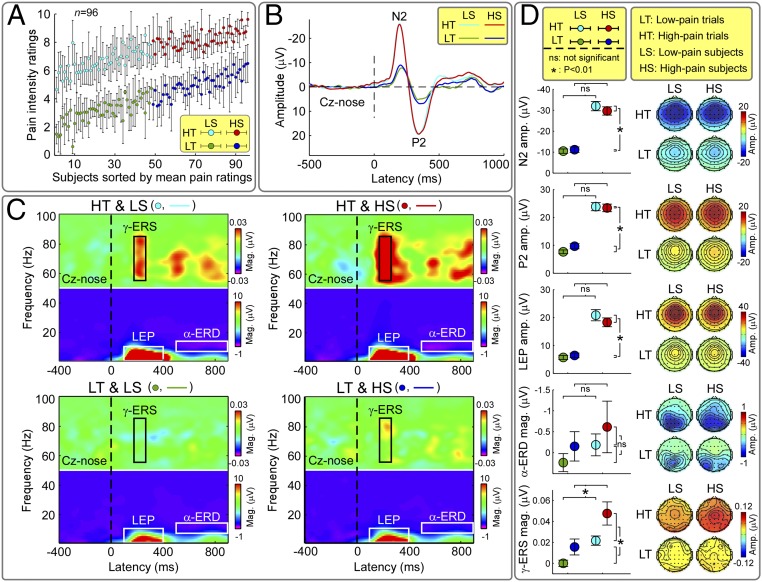
Experiment 1. Interaction of within-subject and between-subject pain intensity effects. Features of the EEG responses were compared using a two-way mixed-design ANOVA, with a within-subject factor (two levels: low-pain and high-pain trials) and a between-subject factor (two levels: low-pain and high-pain subjects). (A) Participants were sorted by mean pain rating across trials and median-split into low-pain subjects (green/cyan, left) and high-pain subjects (blue/red, right) (n = 48 each). In each subject, trials were sorted by pain ratings and median-split into low-pain trials (green/blue, bottom) and high-pain trials (cyan/red, top) (n = 20 each). (B) Time-domain analysis. Group-level ERPs were markedly different between low-pain and high-pain trials, but not between low-pain and high-pain subjects. (C) Time-frequency analysis. Group-level TFDs for low-pain (Bottom) and high-pain (Top) trials of low-pain (Left) and high-pain (Right) subjects, respectively. All TFD features were markedly different between low-pain and high-pain trials. Only the γ-ERS was clearly different between low-pain and high-pain subjects. (D) Statistical comparisons and scalp topographies of neural responses. N2-wave and P2-wave amplitudes, as well as LEP magnitude, were significantly larger in high-pain than in low-pain trials, but not different between low-pain and high-pain subjects. α-ERD magnitude was not significantly different between low-pain and high-pain trials, or between low-pain and high-pain subjects. γ-ERS magnitude was larger both in high-pain than low-pain trials (P < 0.001), and in high-pain than low-pain subjects (P = 0.005). The lack of interaction between trial type and subject type indicates that the ability of γ-ERS to predict pain both within- and between-subjects was not driven by a small number of highly pain-sensitive individuals.